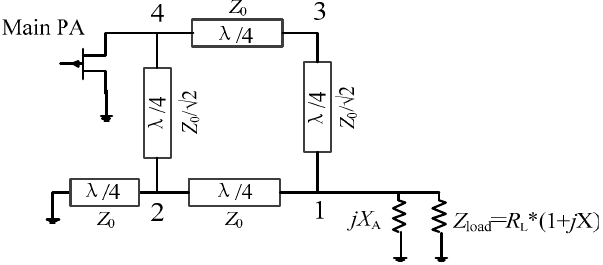
Figure 2. ( a ) Proposed DPA topology; ( b ) modified coupler.